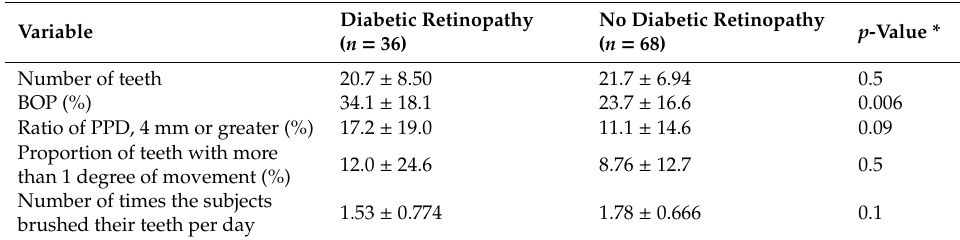
Table 4. Characteristics of the groups with and without diabetic